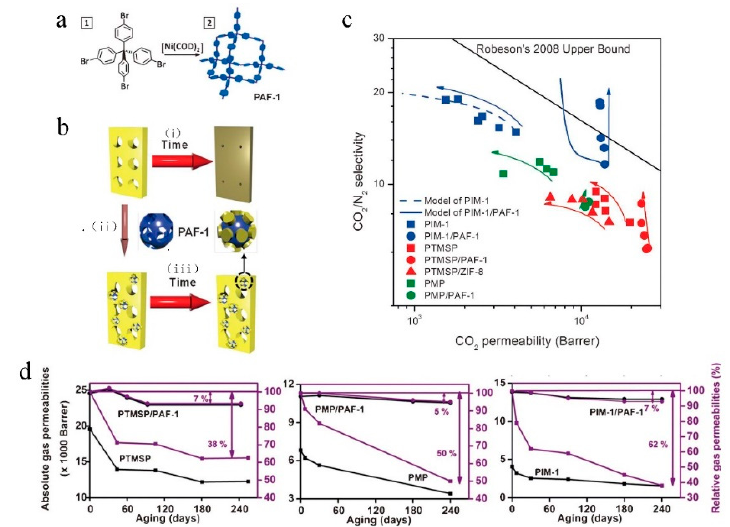
Figure 16. ( a ) Synthesis of PAF-1 particles. ( b ) Super glassy polymer/PAF-1 intermixing. Typically (i) PTMSP, PMP, and PIM-1 densify to give a non-permeable conformation, (ii) but with the addition of PAF-1, (iii) the original permeable structure is maintained. ( c ) Single gas CO 2 permeability and ideal CO 2 /N 2 selectivity of PTMSP (red), PMP (green), and PIM-1 (blue) based nanocomposites are plotted on Robeson Upper Bound. Te squares represent pure super glassy polymer films, circles represent super glassy polymer/PAF-1 films, and triangles represent super glassy polymer/metal–organic framework films. Our model accurately predicts the ging trends in different systems. Ultimately, PAF-1-based nanocomposites perform better over time without any CO 2 permeability loss. The arrows provide a visual guide to show the relationship between CO 2 permeability and selectivity over time (aging is tracked from the bottom of each arrow). ( d ) Absolute (black) and relative (purple) CO 2 permeabilities of PTMSP-, PMP-, and PIM-1-based membranes, pristine polymers (squares), and polymer/PAF-1 (circles) membranes. Lines are drawn to guide the eye. The deviation of these permeability measurements is within ±10%. Purple arrows show the aging degree in these membranes. Adapted from Reference [90].